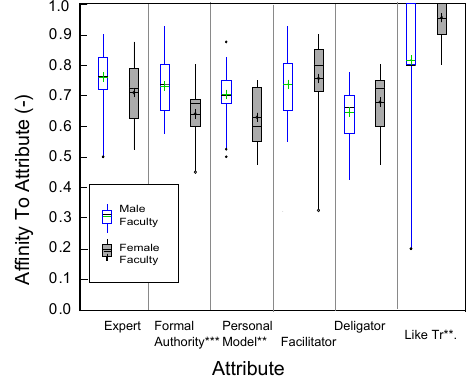
Fig. 3. Di ff erences in teaching-style and inclination to have didactic training between male and Fig. 3. Differences in teaching-style and inclination to have di- female respondents. ∗ indicates p< 10%, ∗∗ p< 5% and ∗∗∗ p< 1%. dactic training between male and female respondents. ∗ indicates p < 10%, ∗∗ p < 5% and ∗∗∗ p < 1%.